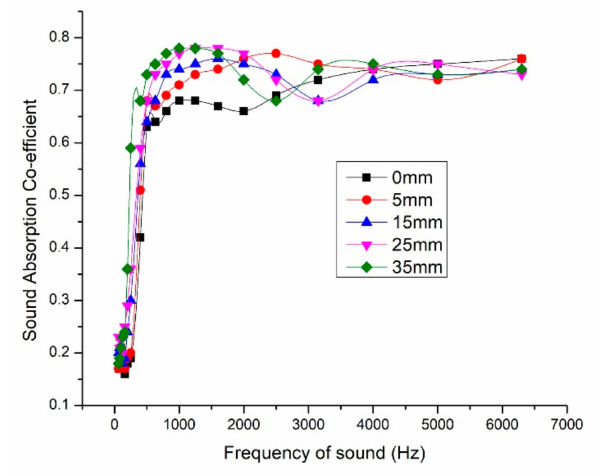
Figure 8. Variation of sound absorption coe ffi cient with varying air gap